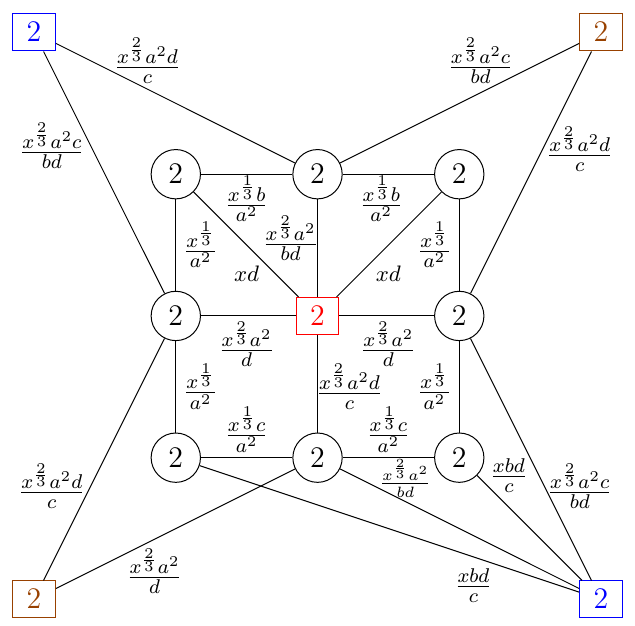
√ 2; 1 , 1 , 1 , 1 , 0 , 0) with a specific